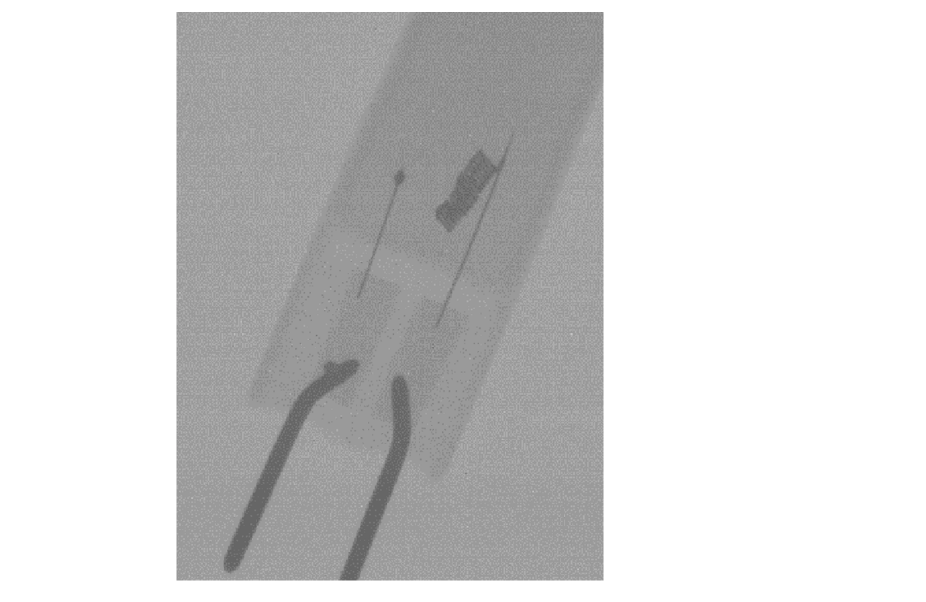
Figure 8. Halogen lamp radiography on the Remote RadEye HR (70 kVp 20 mAs).